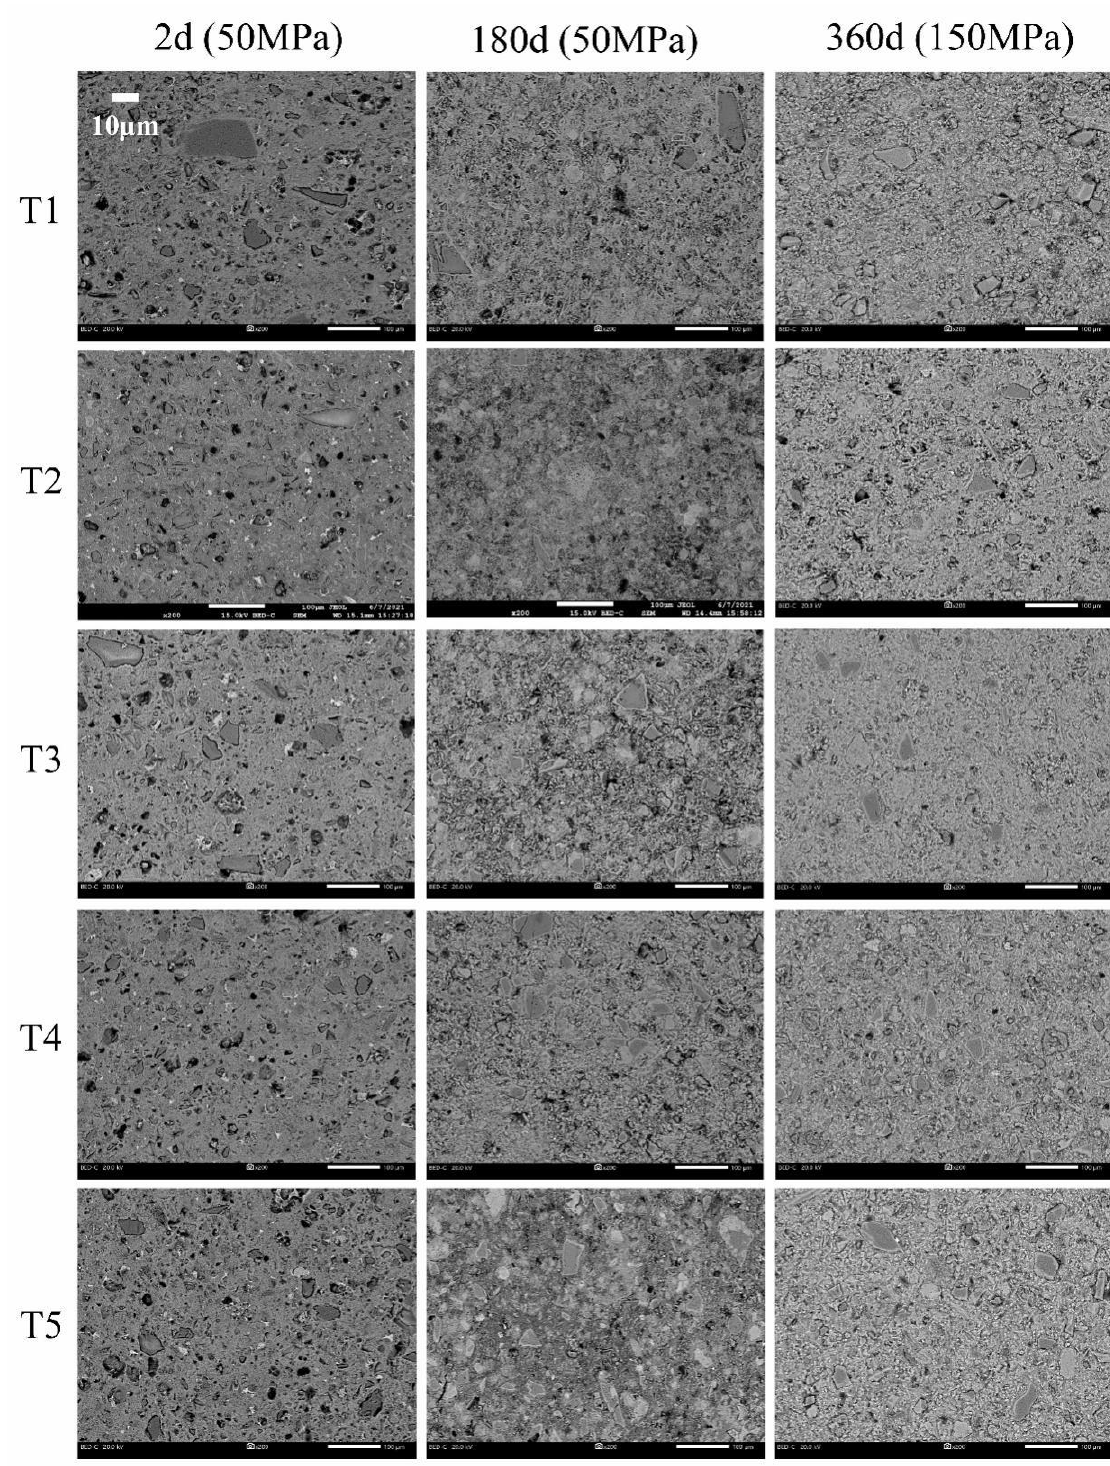
Figure A2. SEM-BSE analysis of slurries T1 to T5 (×200).